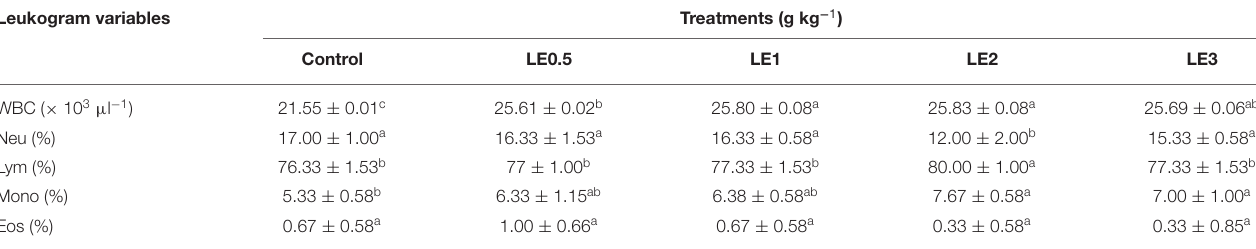
TABLE 2 | Blood cell response of rainbow trout fed with diet containing different levels of licorice extract (LE) for 56 days*. Leukogram